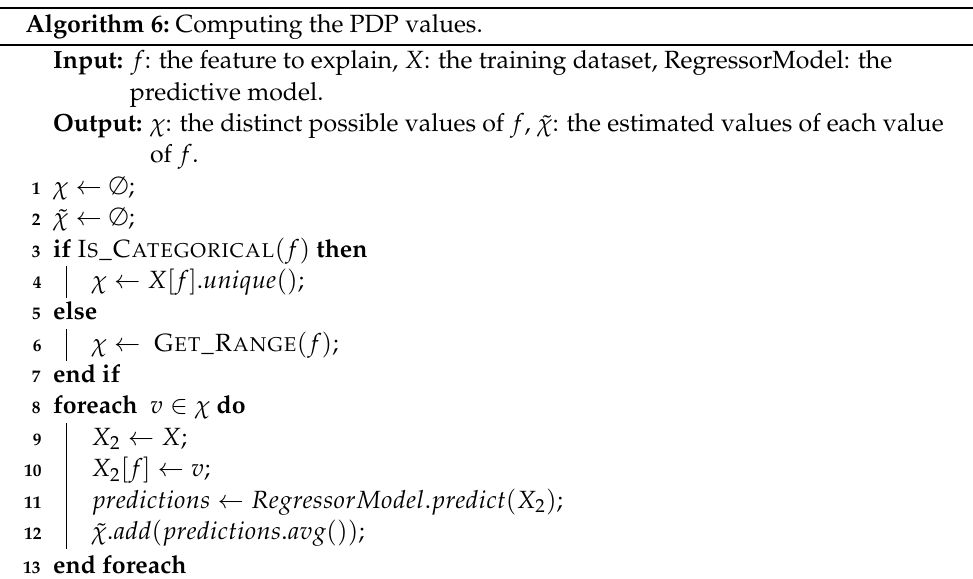
Algorithm 6: Computing the PDP